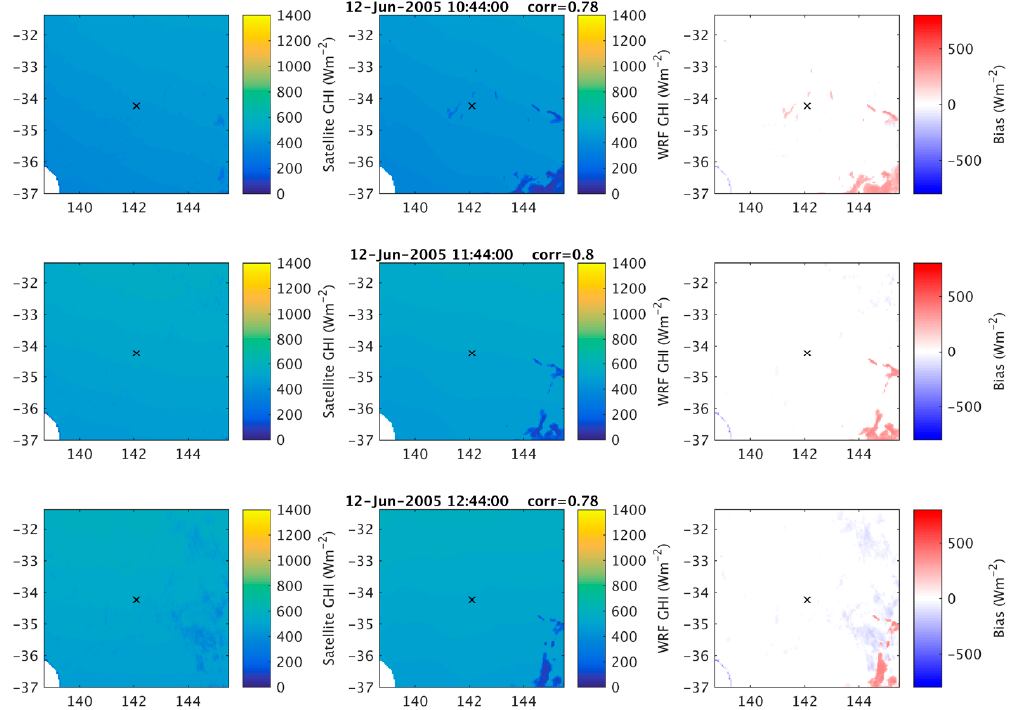
Figure 10. Spatial distribution of GHI observed from the satellite (left), simulated by WRF-Solar (centre), and the bias (right) for intermittent case on 12 June at three satellite overpassing times (top to bottom).